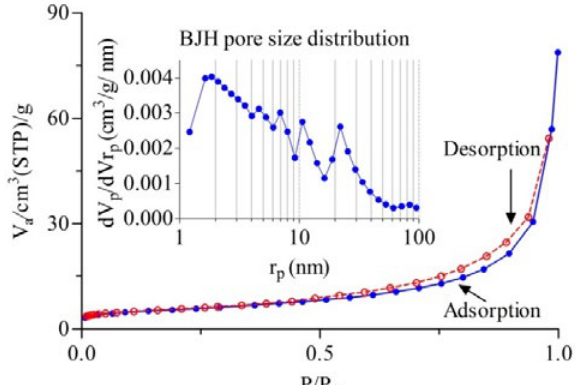
Fig. 1: Adsorption- desorption isotherm of N 2 for BET and BJH pore size distribution plots of the adsorbent